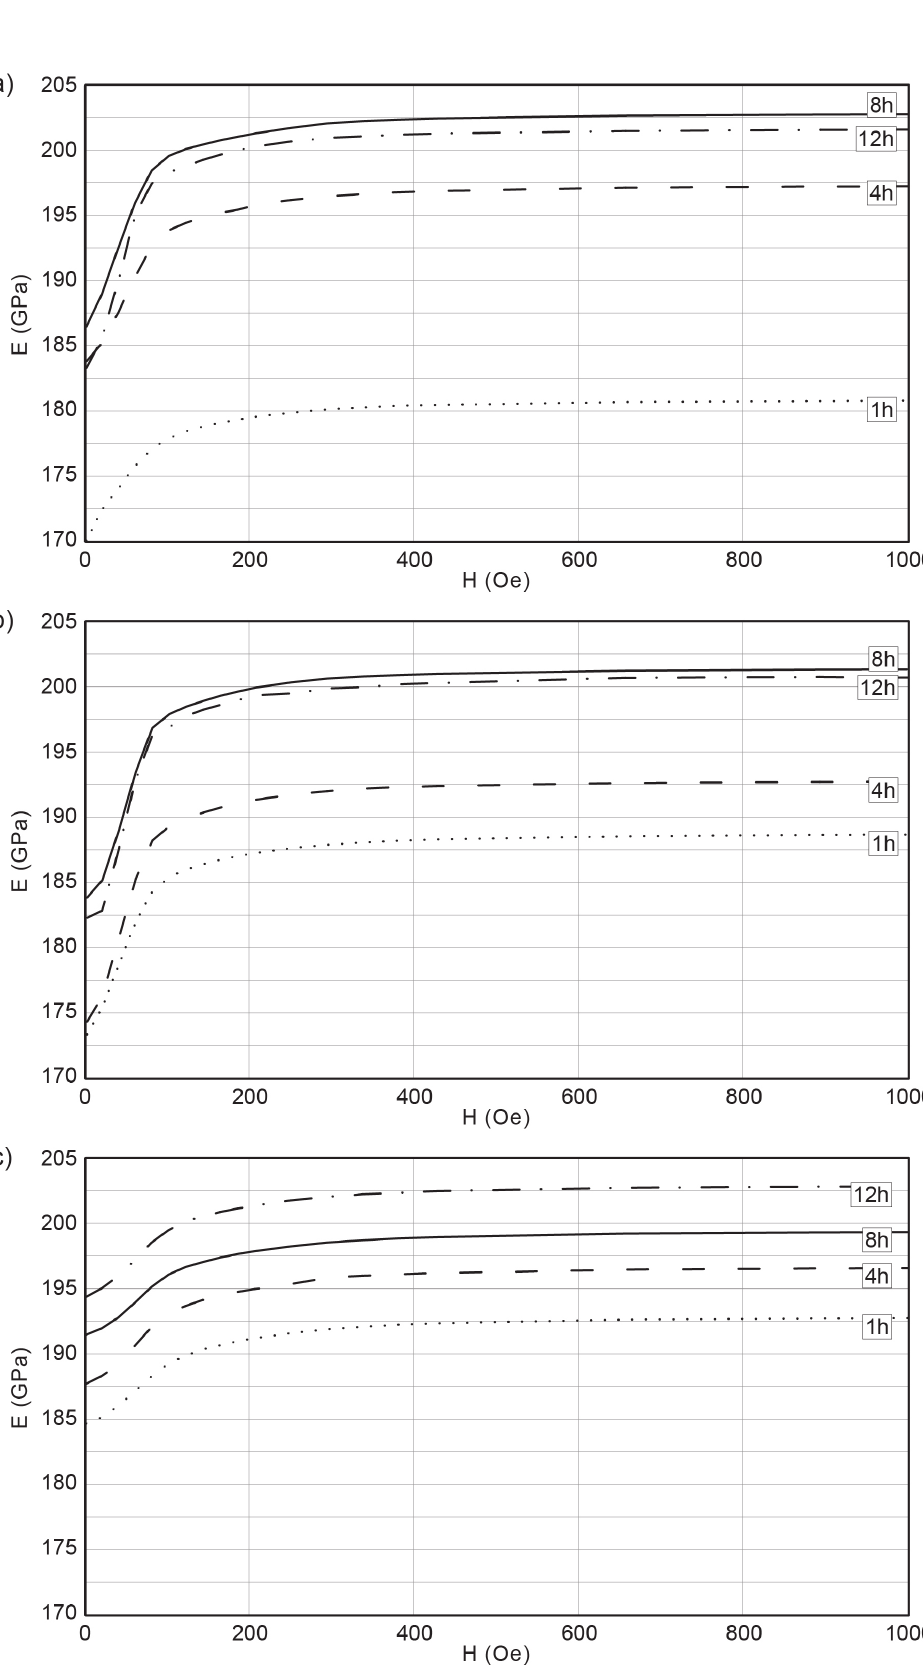
Figure 11. ∆ E-effect after sintering at 1325 °C for holding times of 1 h, 4 h, 8 h and 12 h under ( a ) N 2 -5%H 2 , ( b ) N 2 -10%H 2 - 0.1%CH 4 , and ( c ) low